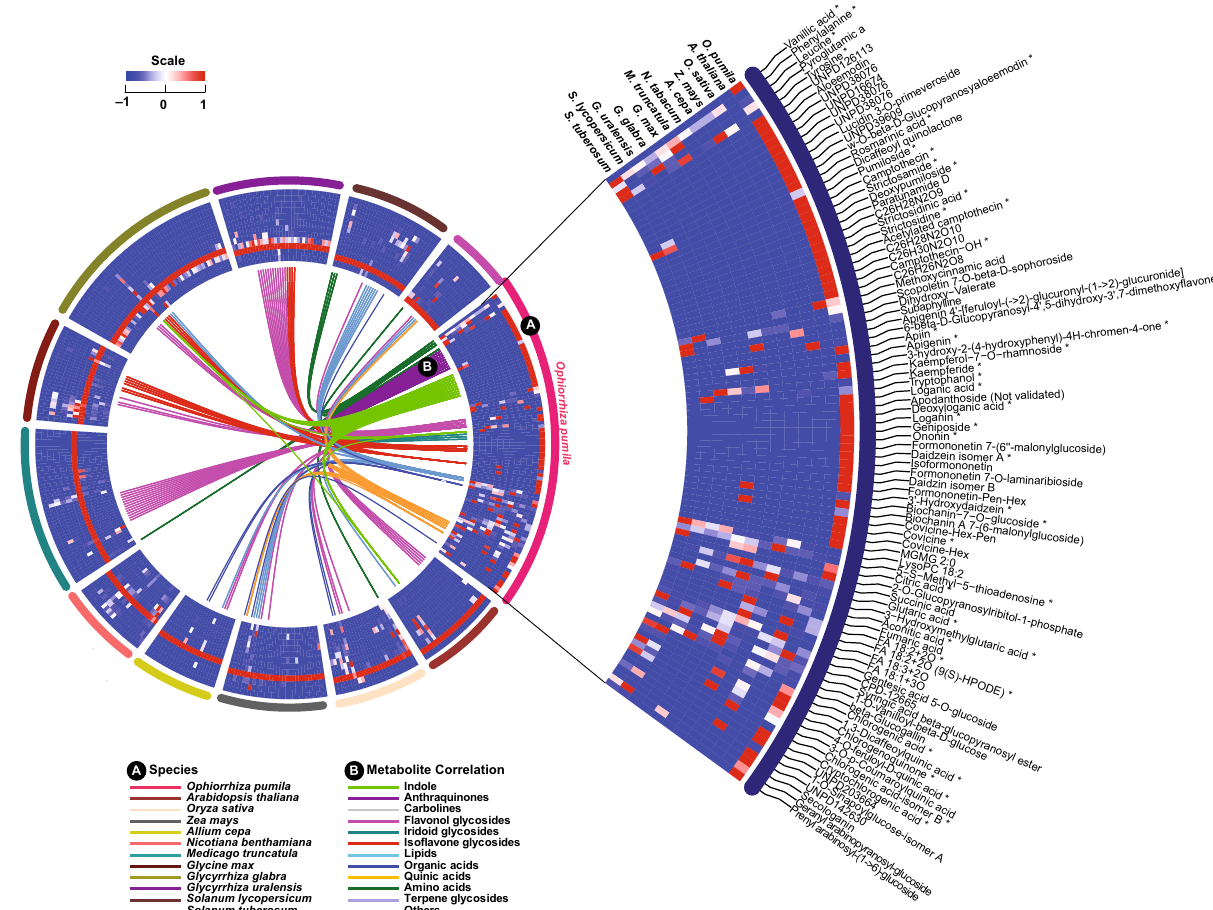
Fig. 4 Ophiorrhiza pumila metabolome, assigned using 13 C and 15 N stable isotope labeling, compared with metabo-space of 11 plant species. Circuit A shows plant species used to compare metabolome space with that of O. pumila , and circuit B shows the connections between metabolite features, and are based on metabolite network relationships de fi ned by a correlation coef fi cient >0.85. Highly accumulated metabolites across 12 plant species and their relationships in the form of metabo-ontology and scaled accumulation levels as a heat map are shown here. Metabolites were fi ltered (log10 intensity>3.9) and assigned to the O. pumila category. If a metabolite was not detected in O. pumila , then it was assigned to the plant category with the highest accumulation compared to the rest of the plant species. *Indicates chemically assigned metabolites based on pure standards or MS/MS analysis using public databases. Source data are provided as a Source data fi in the root and hairy root, and low expression in the leaf and cell